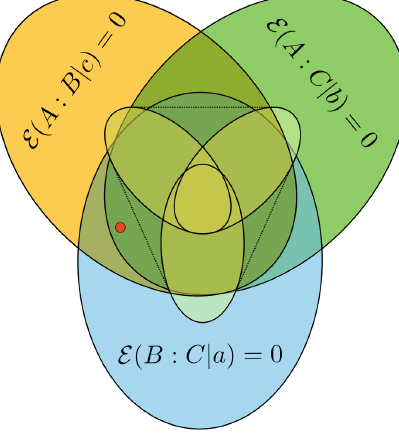
Figure 12: GME combs without creatable entanglement. In the main text, we provide a comb that lies outside the convex hull of separable combs, i.e., it is GME, but does not display any conditional entanglement. Exemplarily, this processes is depicted by a red